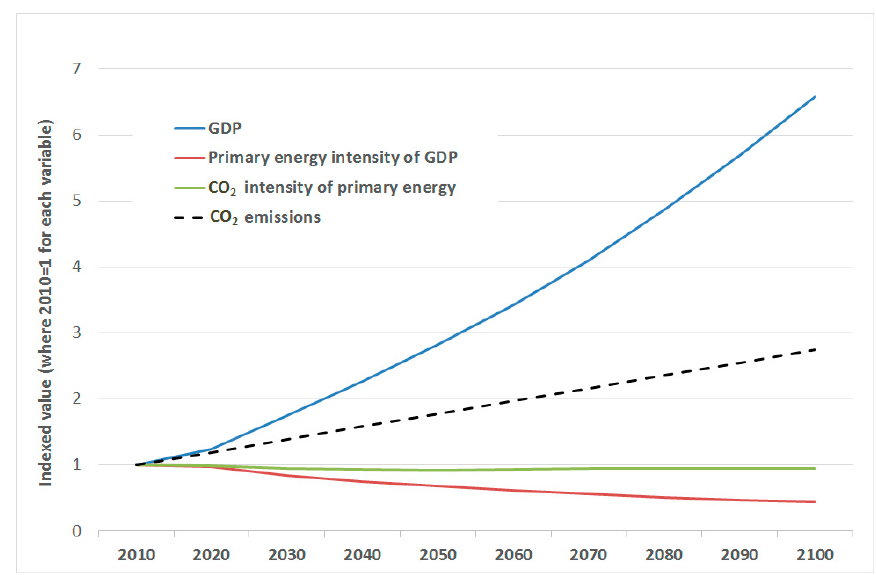
Figure A3. CO 2 emissions in the reference scenario, and decomposed to show the change in each major component over the period 2010–2100.